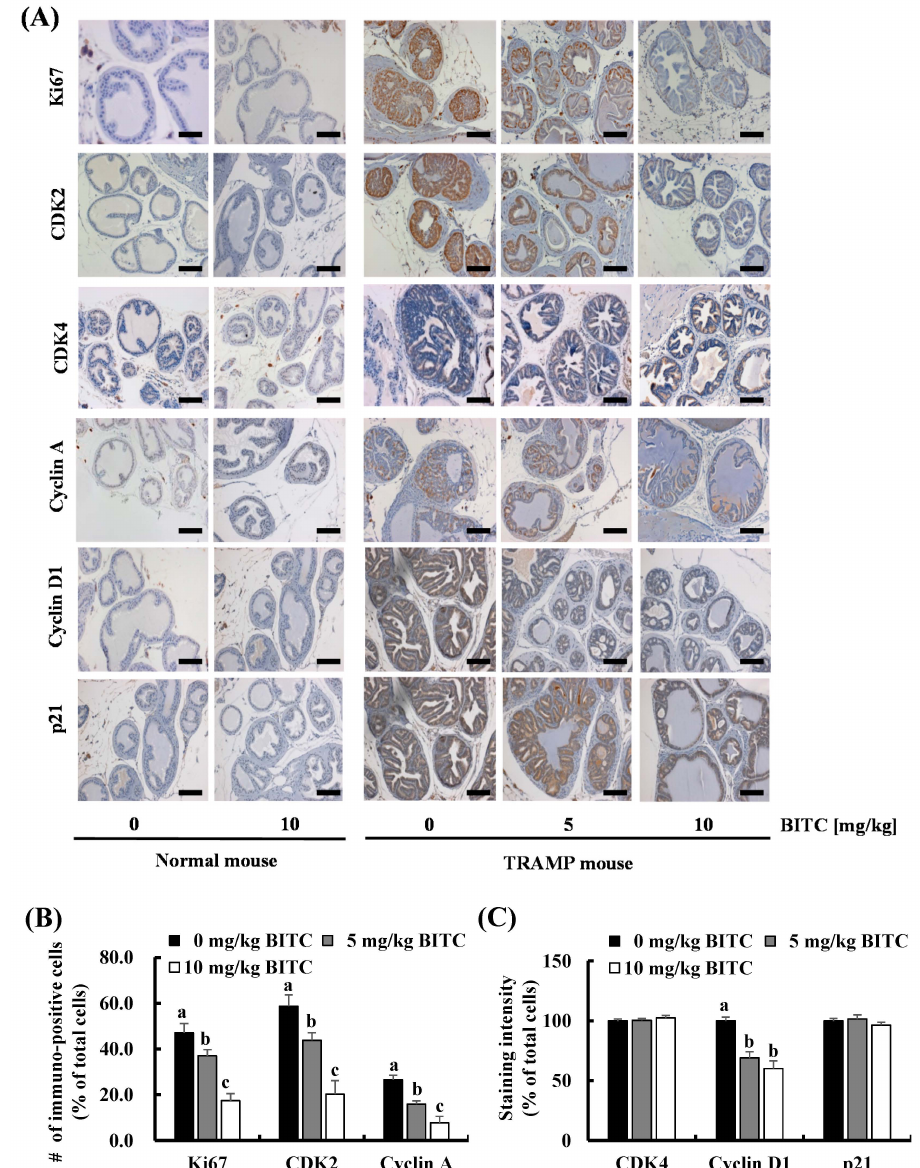
Figure 2. BITC administration reduces the expression of Ki67, CDK2, cyclin A, and cyclin D1 in the prostate epithelium. The prostate sections were immunohistochemically stained using a Ki67, CDK2, CDK4, cyclin A, cyclin D1, or p21 antibody. ( A ) Representative photographs of DAB-stained tissue specimens; ( B ) The number of immune-positive cells were counted and expressed as a percentage of total cells; ( C ) The staining intensity was quantified and the control groups (0 mg/kg BITC-fed TRAMP mice) were set as 100%. Data represents the mean ˘ SEM ( n = 5). Means without a common letter differ, p < 0.05. Scale bar, 100 µ